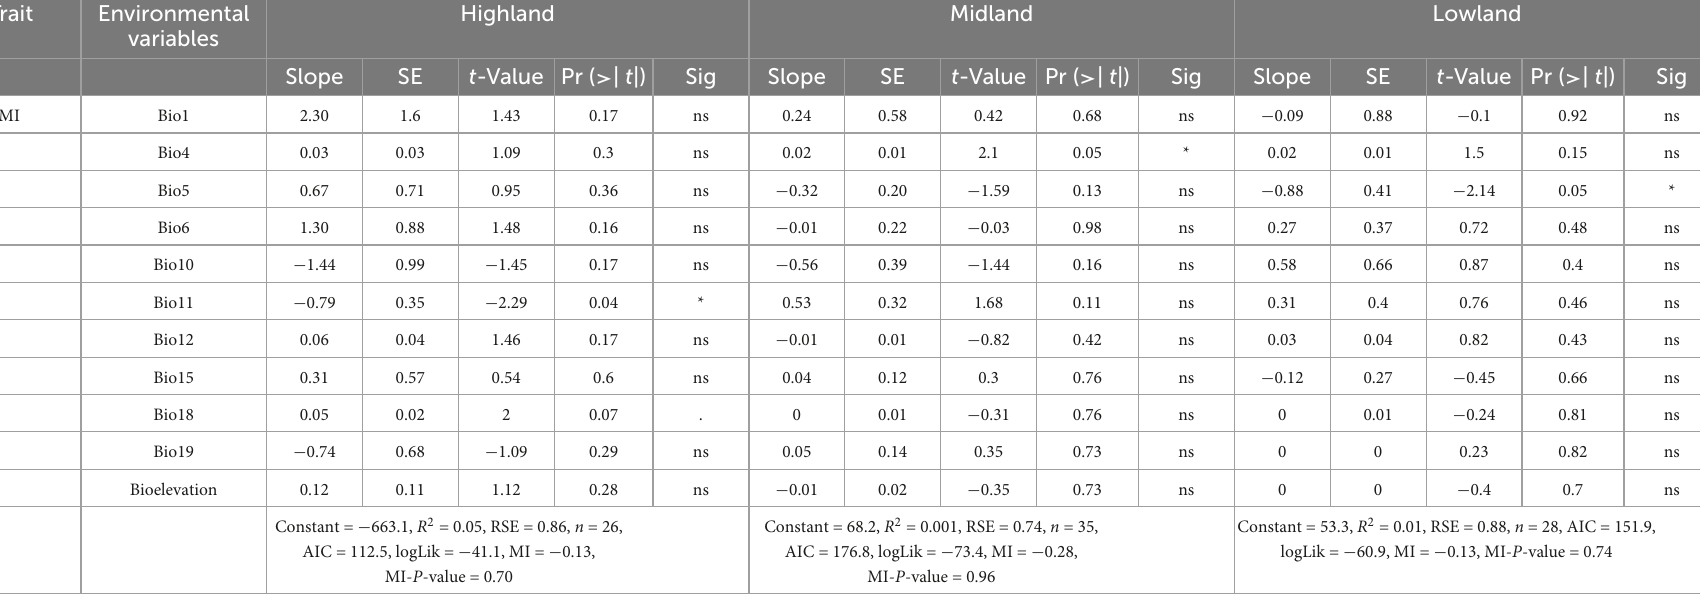
TABLE 2 Relationships (multiple linear regression) between male chicken phenotypes and environmental variables (Bergmann’s rule). Trait Environmental variables